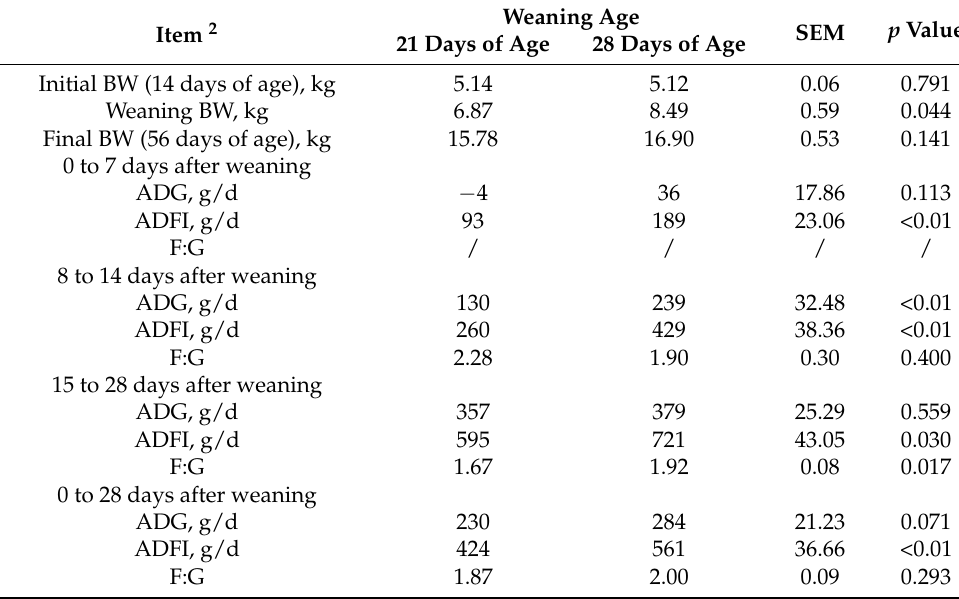
Table 2. Effect of weaning age on growth performance of weaned pigs 1